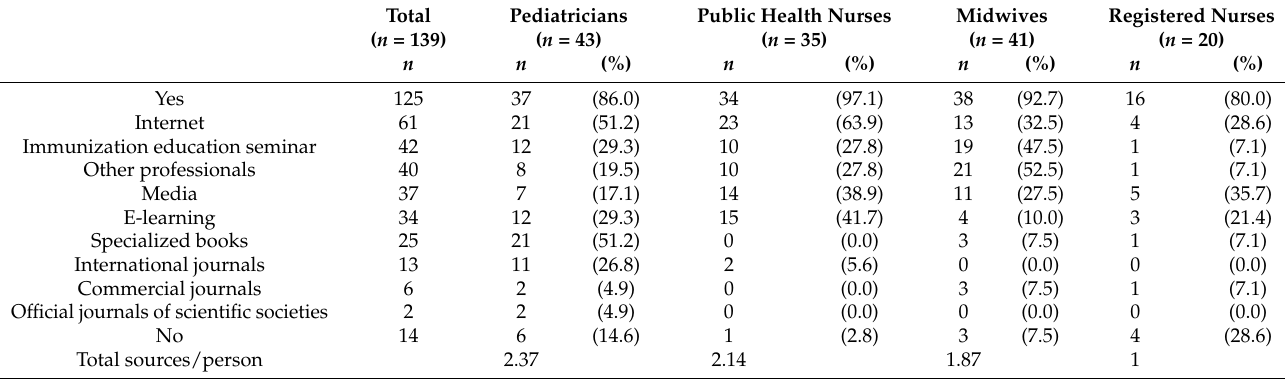
Table 3. Source of immunization information 1 .